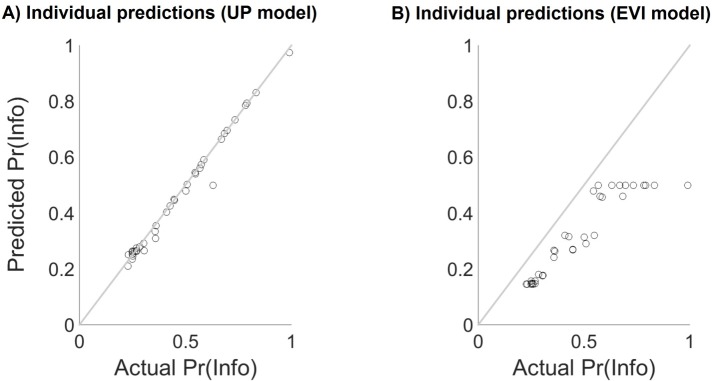
Individual-participant model fits.(A) Actual informative choice proportion, denoted Pr(Info) (horizontal axis) versus informative choice proportion as predicted by the UP model (vertical axis). Each circle indicates one participant. Euclidean distance from the diagonal (grey line) represents error in prediction. (B) Actual informative choice proportion (horizontal axis) versus informative choice proportion as predicted by the EVI model (vertical axis). Each circle indicates one participant. Euclidean distance from the diagonal (grey line) represents error in prediction. Across all participants, the EVI systematically under-predicted informative choice proportions (all participants fell below the diagonal).